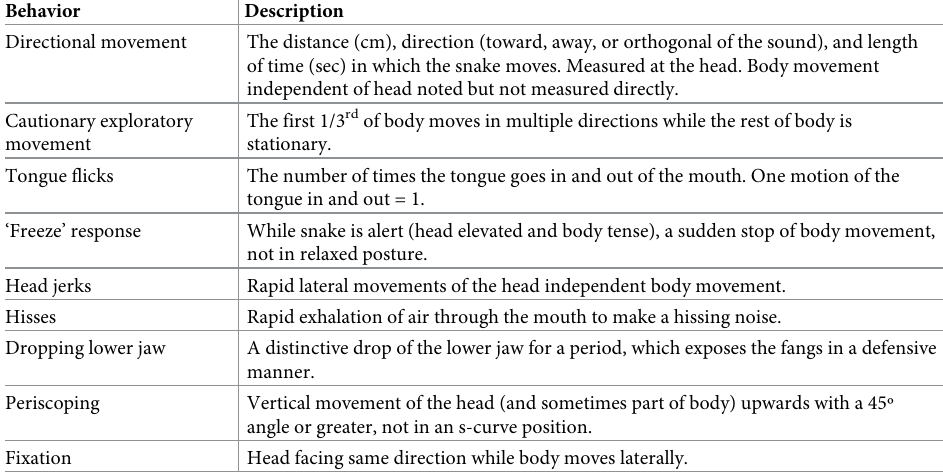
Table 1. Nine behaviors recorded for snakes included in the